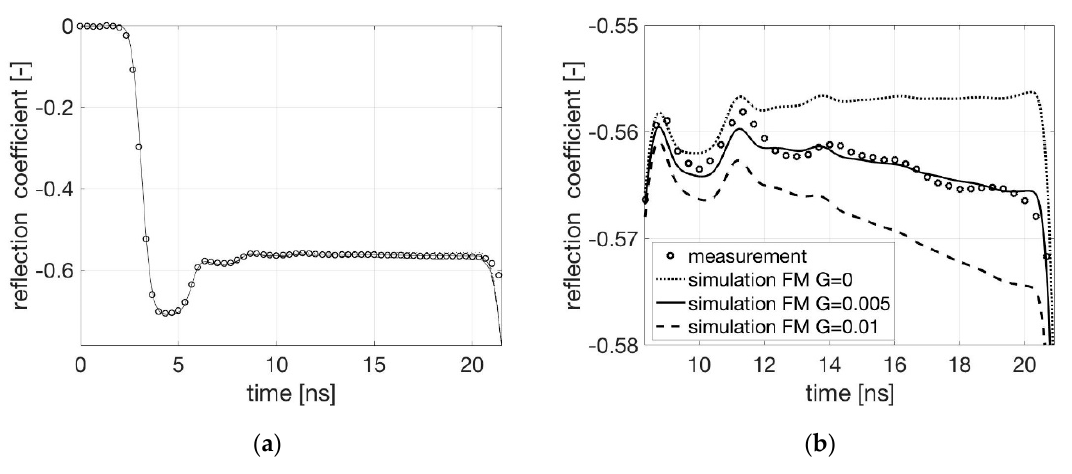
Figure 5. Comparison between measured and modelled TDR signals for only water in the cell and for different G -values with R = 0. ( a ) Entire signal; ( b ) An enlarged section.